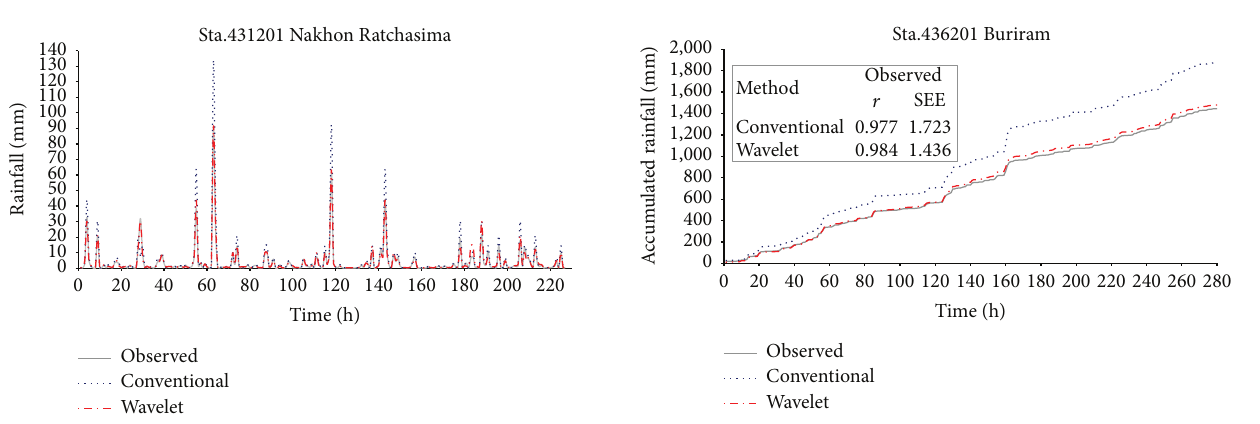
Figure 14: Time series plot of mean observed rainfall at sta.431201 Nakhon Ratchasima compared with conventional and wavelet filters technique.